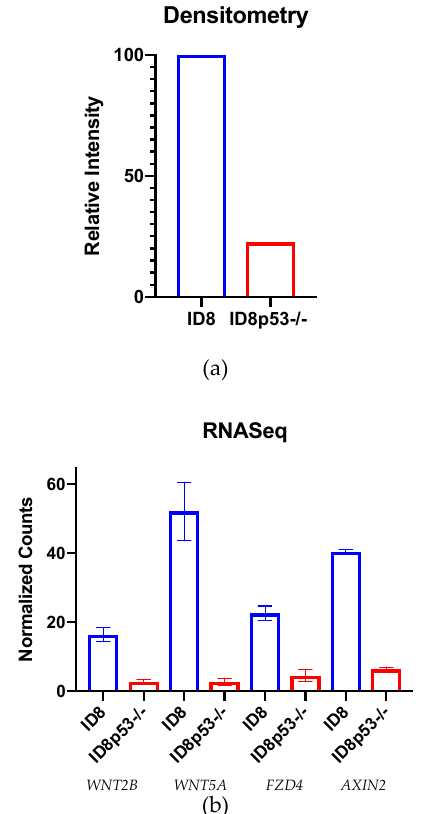
Figure 4. Characterization of the Wnt profile in ID8 and ID8p53 − / − cell lines. ( a ) Western blot with reduced baseline β –catenin levels in the ID8p53 − / − cell line, with densitometry analysis. ( b ) Normalized Wnt related gene expression data for WNT2B , WNT5A , FZD4 and AXIN2 in ID8 ( n = 6) and ID8p53 − / − ( n = 6) was decreased in the ID8p53 − / − cell line compared to the parental ID8 cell line.